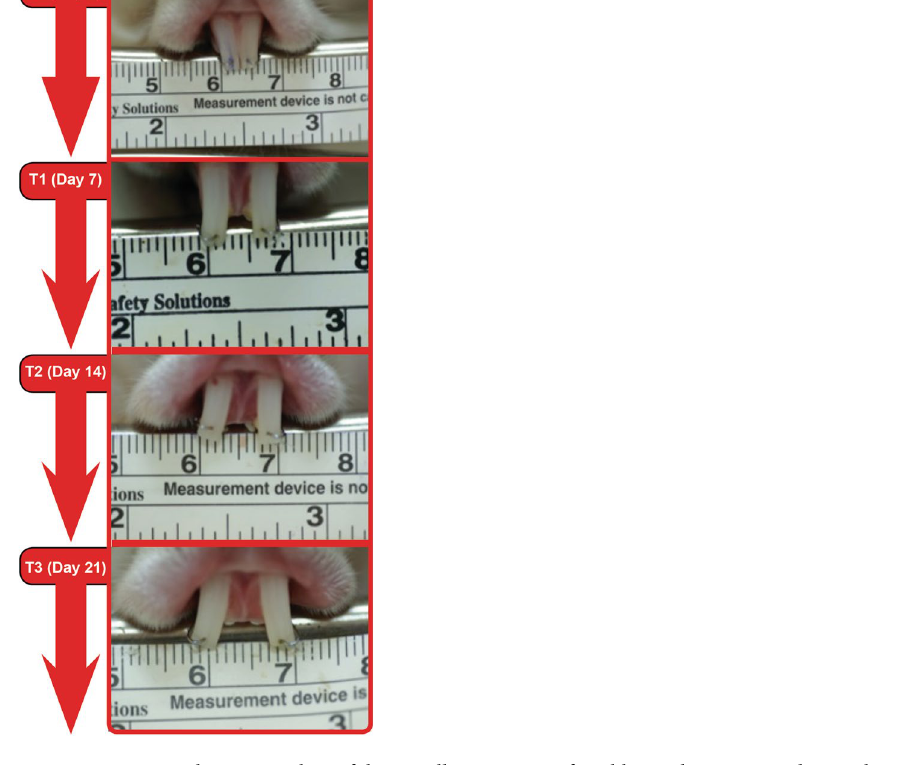
Figure 1. Intra-oral pictures taken of the maxillary incisors of a rabbit in the F1 group during the